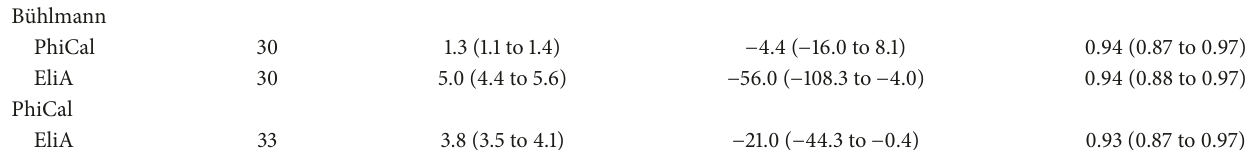
Table 4: Summary of assay performance (Passing-Bablok).